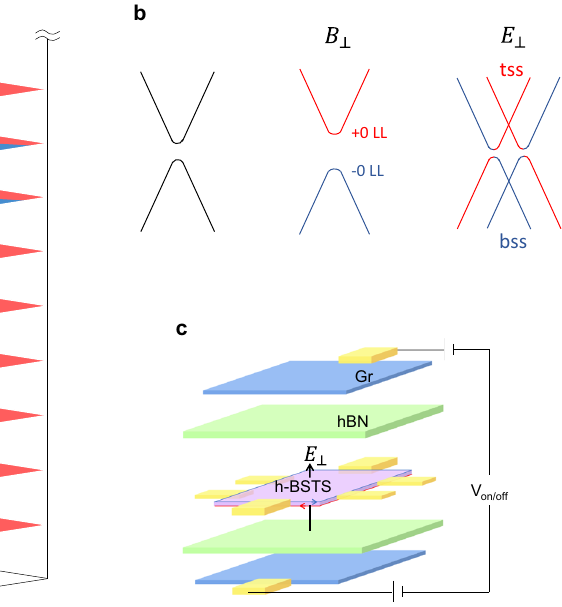
fi elds. b Surface band structure of the hBSTS and its evolution under the external magneticandelectric fi elds.ThezerothLLsbandsresideonthesurfacebandedges are labeled, while the higher order LLs are omitted for simplicity. The transverse electric fi eld shiftsthe top andbottom surfacebandsand resultsin theRashba-like splitting as the illustration. c Schematic of an electric fi eld controlled topological transistor device based on an hBSTS in a vdW dual-gating con fi